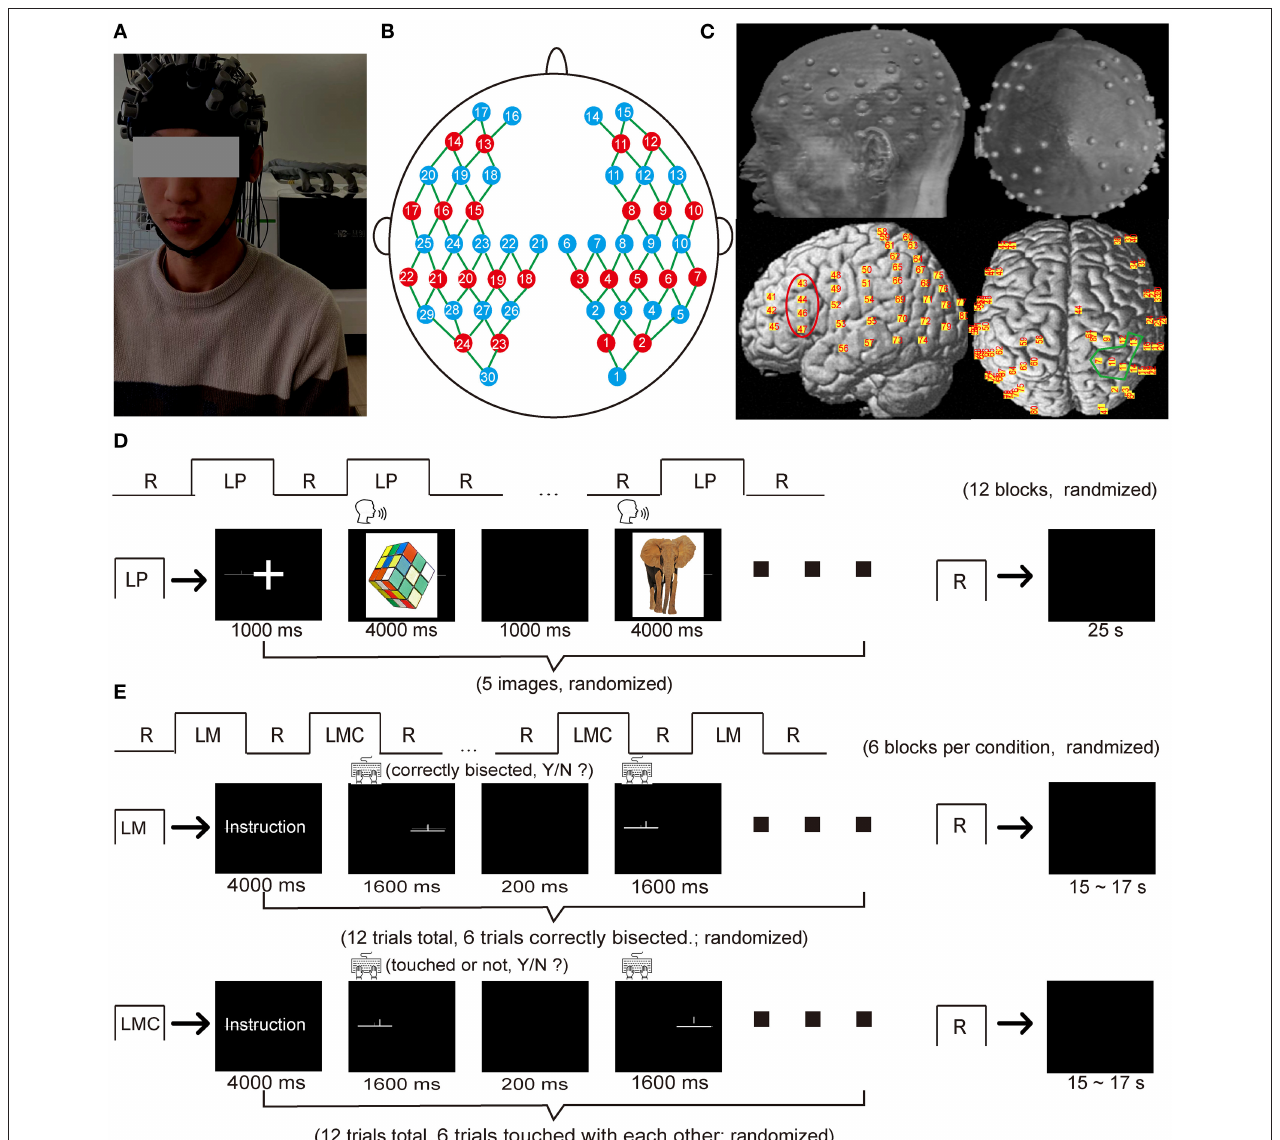
FIGURE 1 | fNIRS optode arrangement and experimental protocol. (A) A photo obtained from a participant during the data acquisition. (B) A schematic of the fNIRS cap (22 sources: red circles, 30 detectors: blue circles) with 80 measurement channels (green line) covering the brain regions of frontal, temporal, parietal, and occipital lobes (C) The structural MRI image with the probe holder in which the gray dots represent the optode positions on the brain scalp, and the yellow dots represent the corresponding channel positions projected onto the brain surface using NIRS-SPM. The red area represented the typical regions activated during the language production task (i.e., the inferior frontal gyrus), and the blue area represented the typical regions activated during the spatial attention task (i.e., the inferior parietal sulcus and the superior parietal lobule). (D) Procedure of the picture-naming task. (E) Procedure of the landmark task. LP, language production (picture-naming task in this study); LM, landmark condition; LMC, landmark control condition; R, rest.